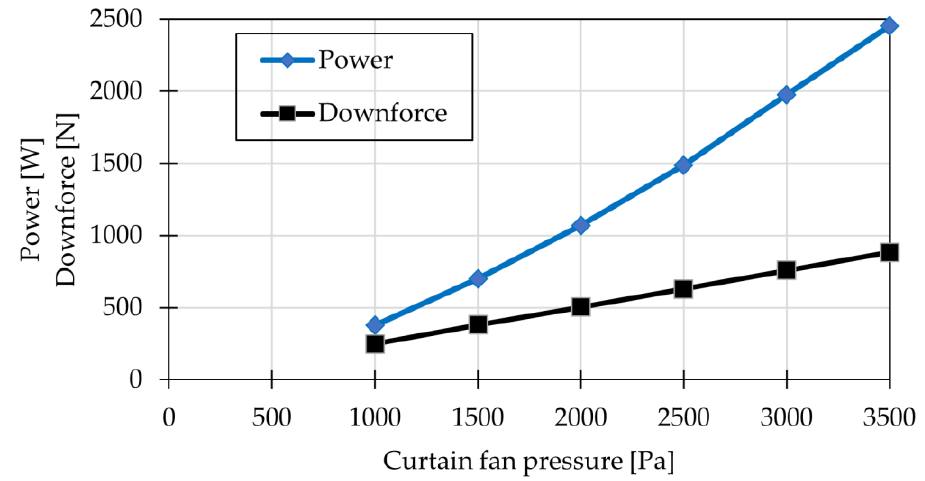
Figure 8. Downforce generated by curtain fan and required power as a function of the curtain fan compression.